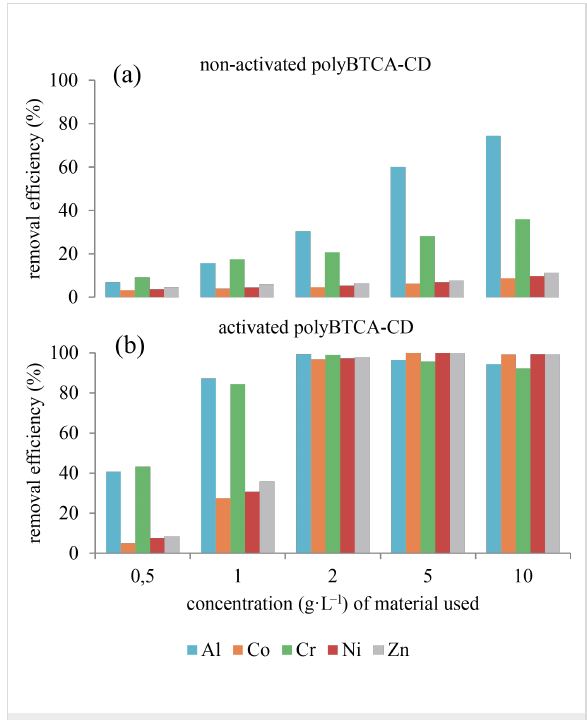
Figure 5: Adsorption capacity (%) of (a) the non-activated and (b) the activated (NaHCO 3 treatment) polyBTCA-CD at different concentra- tions for five metals (at 10 mg·L − 1 metal).